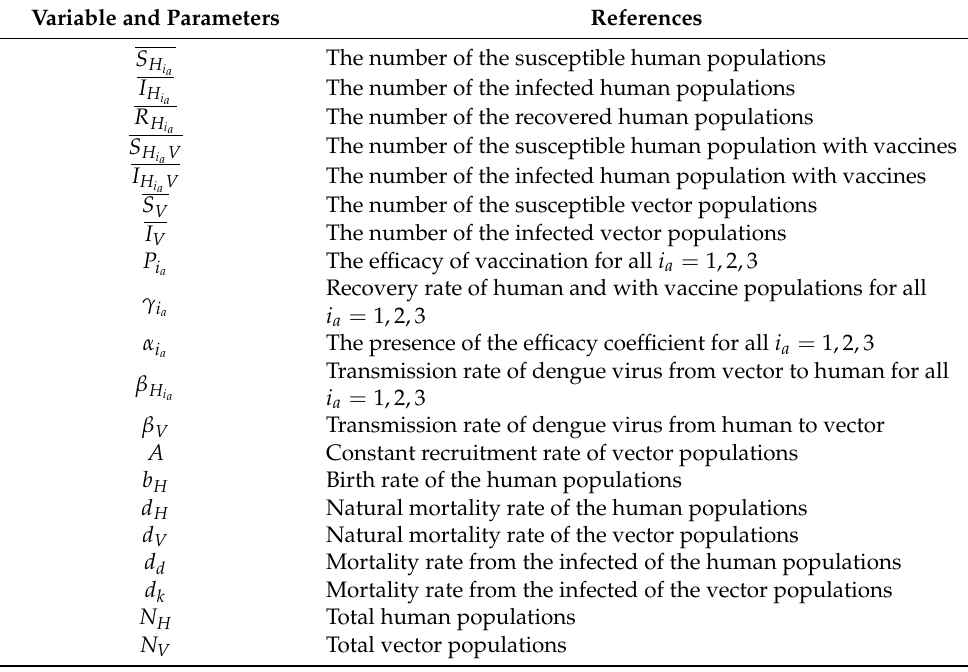
Table 1. The variable and parameters used in the system equation.